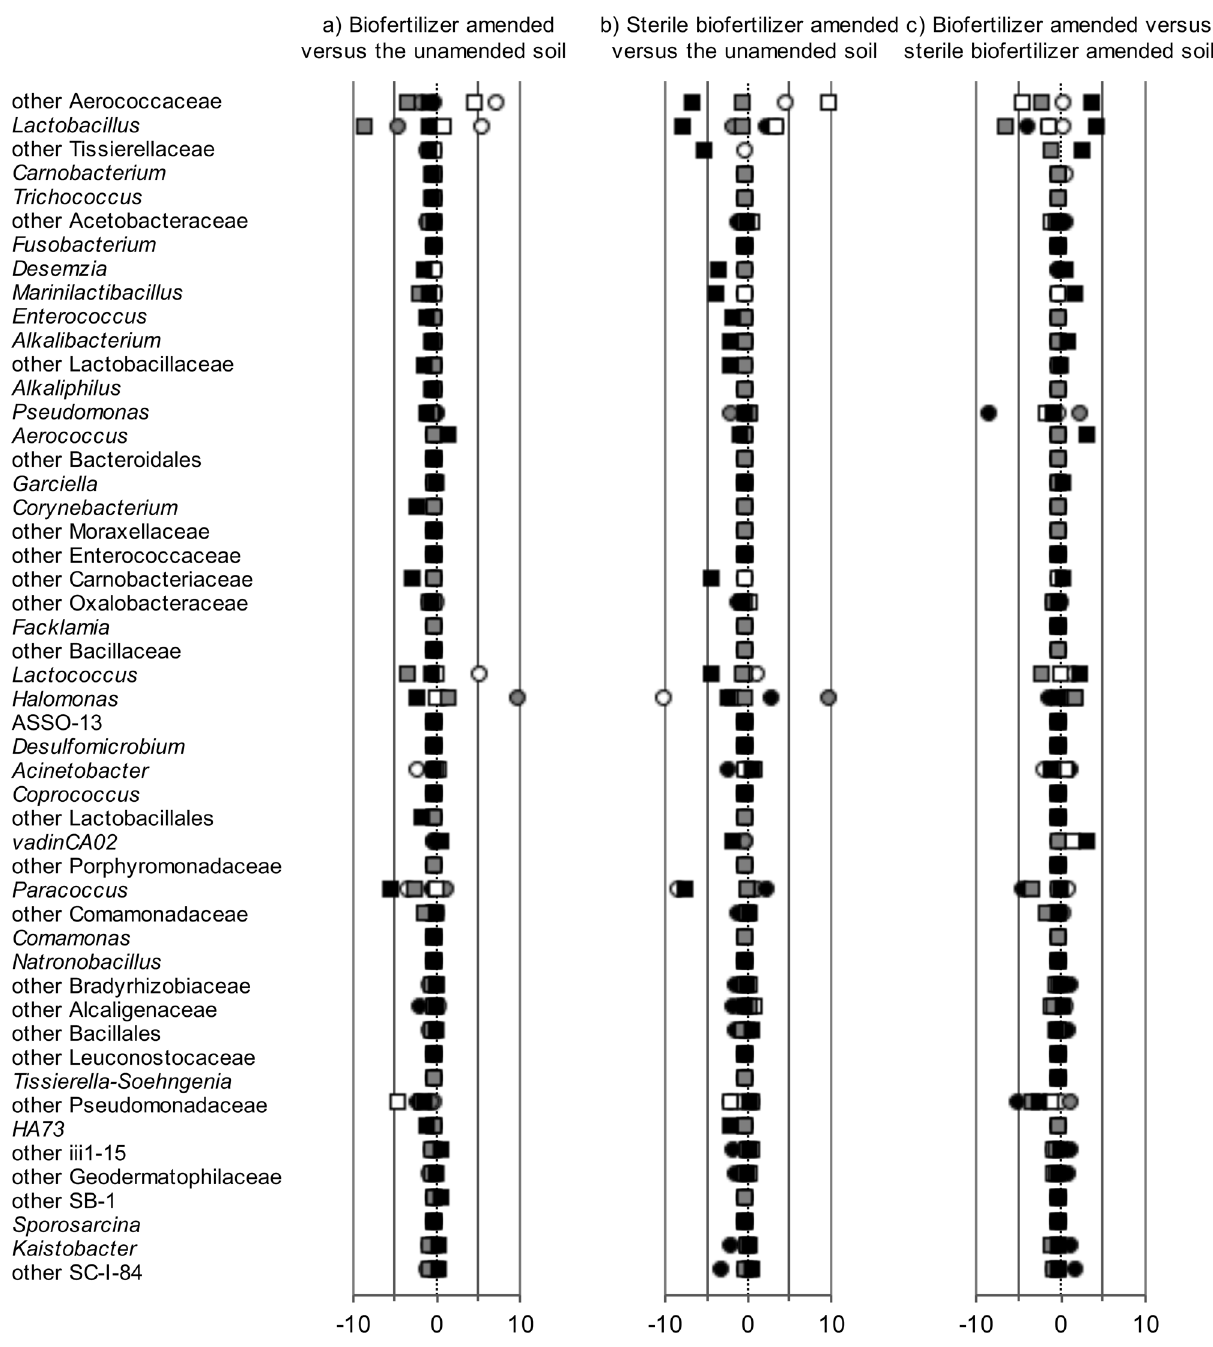
Figure 3. Ratio of the relative abundance of the 50 most abundant bacterial groups assigned up to the taxonomic level of genus applied with the biofertilizer in ( a ) the biofertilizer versus the unamended soil and ( b ) sterile biofertilizer amended versus the unamended soil and ( c ) the ratio in the biofertilizer versus the sterile biofertilizer amended uncultivated soil (white circle), non-rhizosphere soil (grey circle) and rhizosphere soil (black circle) after 89 days or the uncultivated soil (white square), non-rhizosphere soil (grey square) and rhizosphere soil (black square) after 130 (Fig. 2). The PCA and PCoA (Data not shown) showed little effect of application of biofertilizer on the bacterial community independent of the taxonomic level considered, but visualized changes in the composition of the bacterial community structure in the uncultivated soil over time most accentuated when considering all bacterial groups assigned to the level of genus (Supplementary Figs. S2, S3, S4 online). Consequently, the perMANOVA analysis indicated that application of biofertilizer had no significant effect on the bacterial community structure, but time had a highly significant effect considering the bacterial phyla and genera ( P ≤ 0.002).